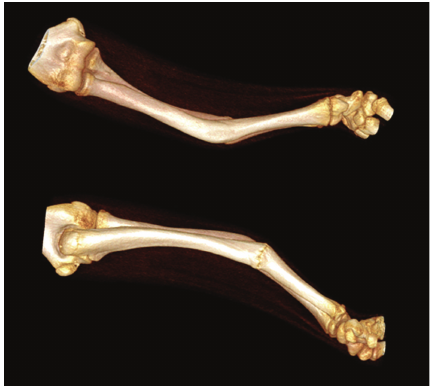
Figure 2: 3D reconstructions of CT data showing the right forearm